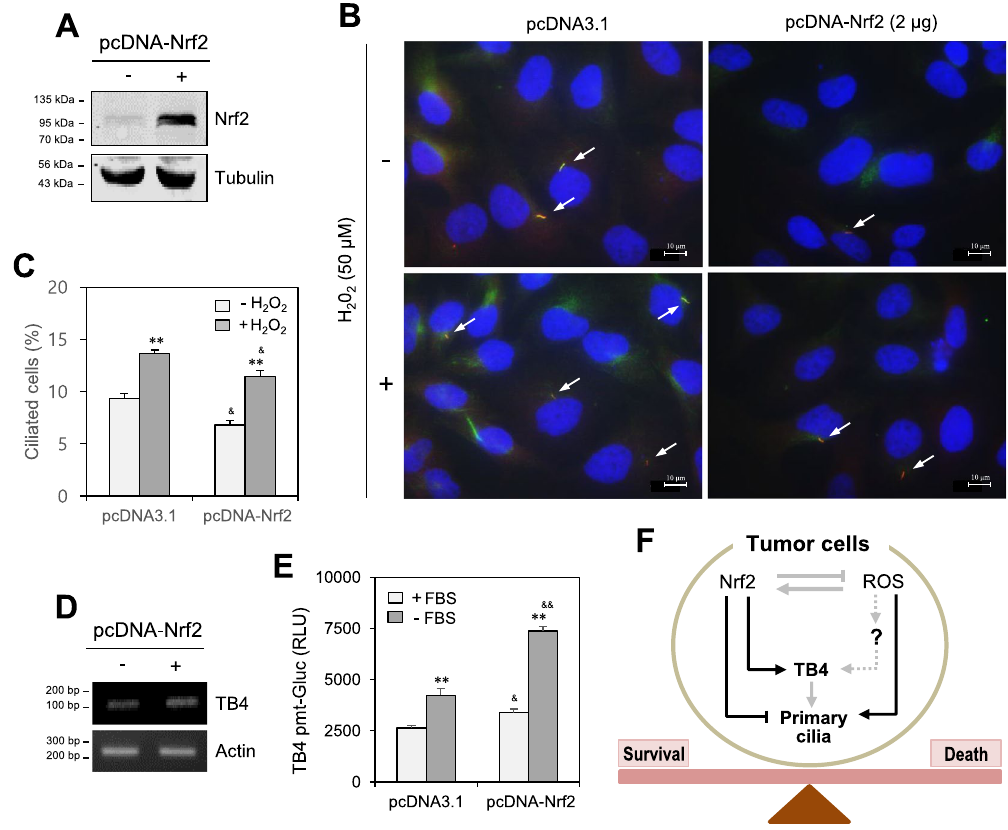
Figure 6. Thymosin beta-4 expression was enhanced by Nrf2-overexpressed cells. ( A – D ) Cells were transfected with pcDNA3.1 or pcDNA-Nrf2 plasmid DNA for 24 h. Nrf2 proteins were detected by western blotting. Processing (such as changing brightness and contrast) is applied equally to controls across the entire image. Original images of full-length blots were included in the Supplementary Information file ( A ). HeLa cells were treated with 50 μM of H 2 O 2 for 24. Cells were fixed and stained with antibody against Ac-tubulin (green), Arl13b (red) and DAPI (blue). The representative image of primary cilia was observed with 1000X magnification under fluorescence microscope. White arrows indicated primary cilia ( B ). The number of ciliated HeLa cells out of more than 1000 cells were counted. PC frequency was evaluated by the blinded double scoring ( C ). The mRNA expression of TB4 was detected by RT-PCR ( D ). ( E ) pEZX-PG02-TB4-promoter Gaussia luciferase (Gluc) plasmids were co-transfected with pcDNA3.1 or pcDNA-Nrf2 plasmid DNA into HeLa cells. Then, cells were incubated in the presence or absence of FBS. The activity of Gluc in cultured media was measured with luminometer using Gluc substrate. Each result was the representative of experiments performed at least four times and each experiment was performed with four samples (n = 4) in the same group. Data in bar graphs represents the means ± SD. * p < 0.05, ** p < 0.01; significantly different from H 2 O 2 -untreated ( C ) or 5% FBS- treated group ( E ). & p < 0.05; && p < 0.01; significantly different from pcDNA3.1-transfected and H 2 O 2 -untreated or -treated group ( C ) or 5% FBS- or 0% FBS-treated group ( E ). ( F ) Schematic summary for primary cilia formation by Nrf2 and ROS through TB4 expression to regulate CC survival and death. While Nrf2 conversely regulated primary cilium formation and TB4 expression in HeLa human cervical CCs (solid line). ROS also up-regulate TB4 expression through unknown another factors (marked as question mark and grey dotted line). Our findings were indicated by black solid lines. Pathway already known was indicated by grey solid